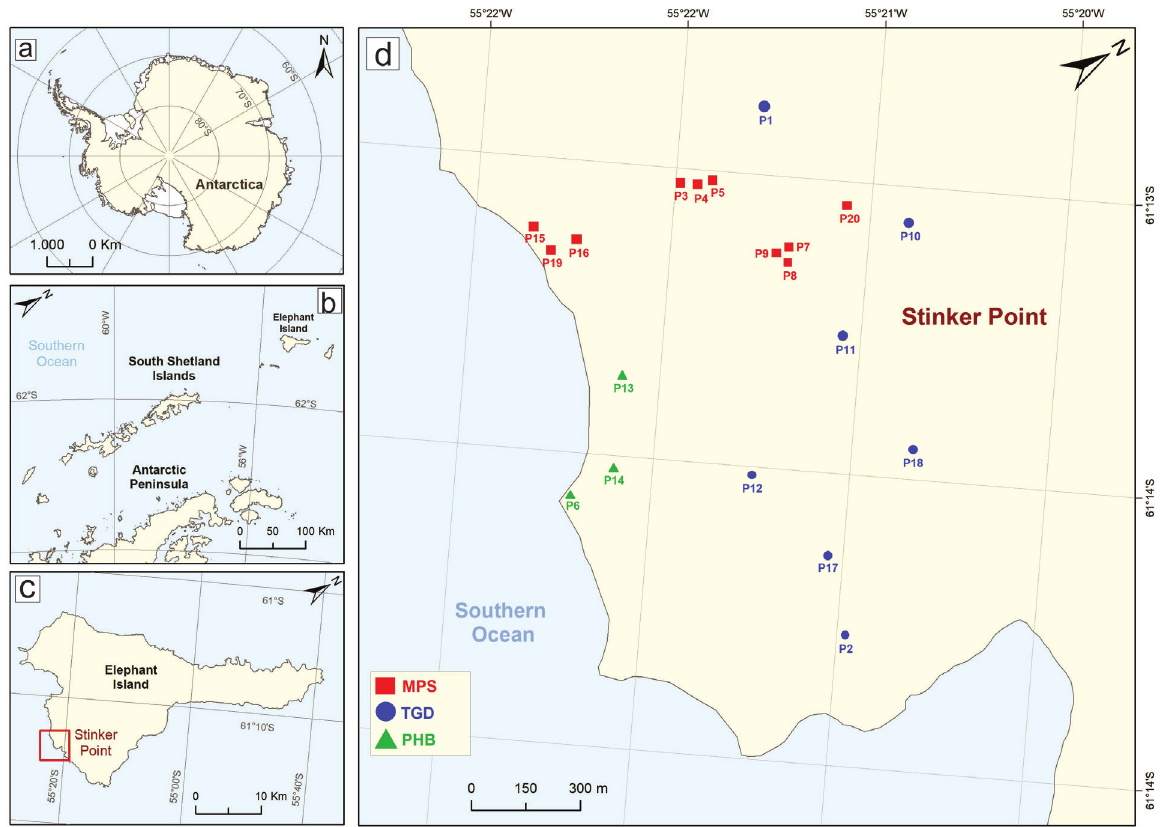
Figure 1. Location of the study area: Antarctica (a), South Shetland Islands (b), Elephant Island (c), Stinker Point with 20 sampled profiles